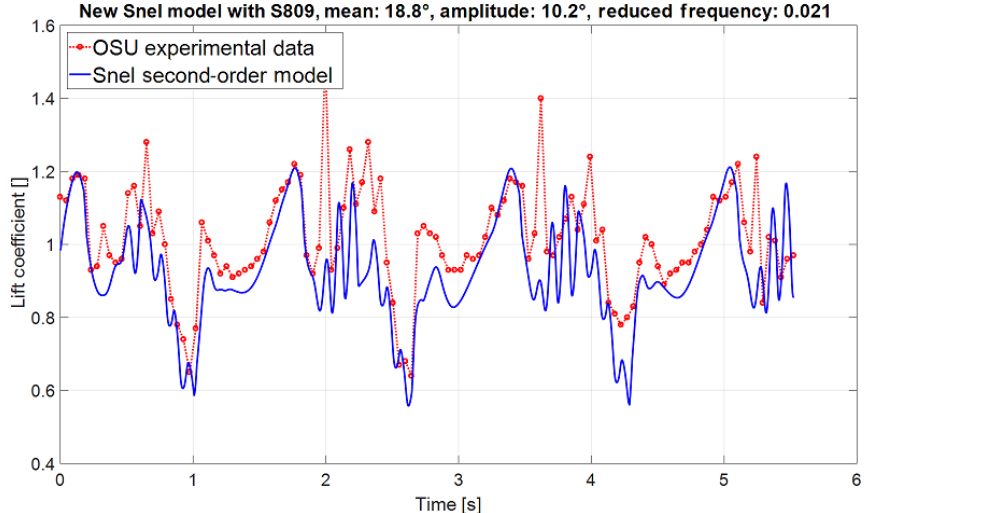
Figure 9. Lift coefficient over time of the improved Snel model (S809 aerofoil with mean angle of attack of 18.8 ◦ , amplitude of 10.2 ◦ , and reduced frequency of